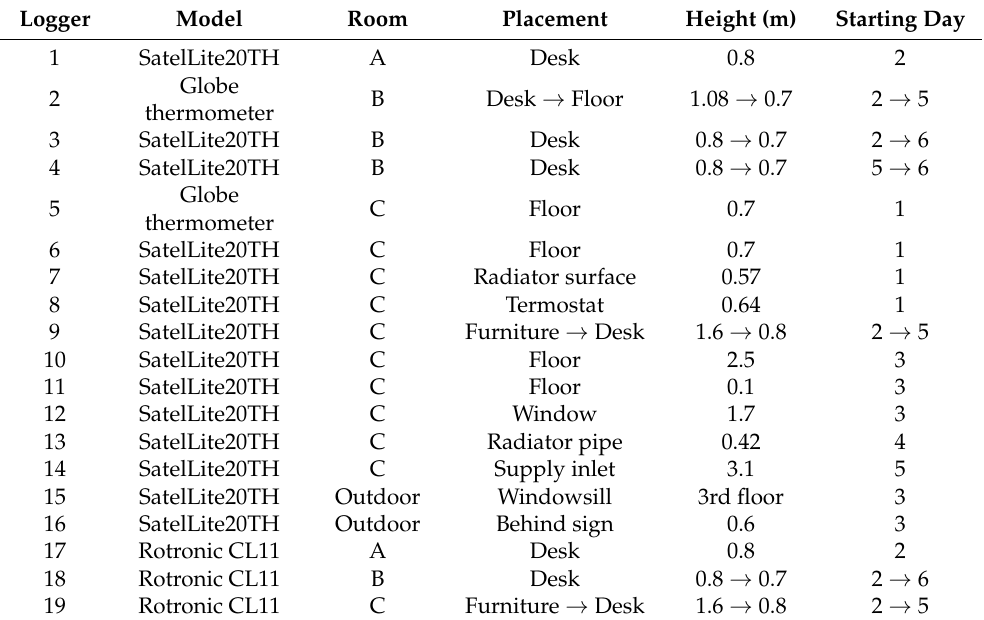
Figure 5. Overview of the building and room location and orientation. 15 and 16 indicate the location of the outdoor sensors.